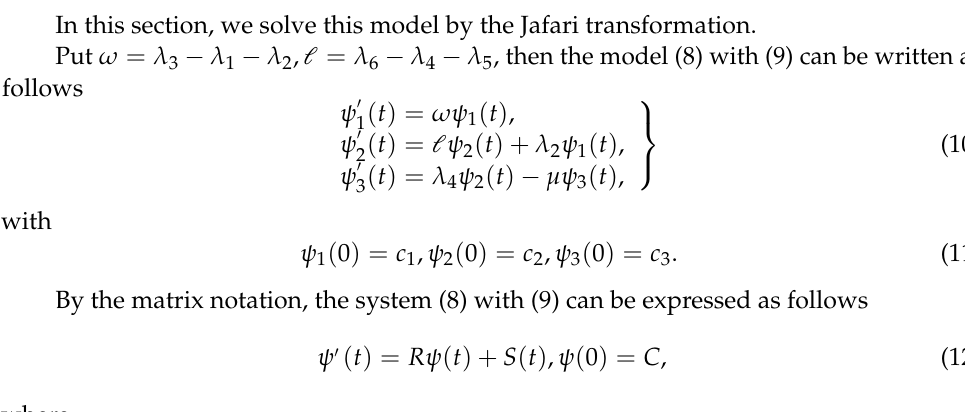
Table 2. The natural explanation of the parameters. Parameter Meaning ψ 1 ( t ) number of stem cells ψ 2 ( t ) number of semi-differentiated cells ψ 3 ( t ) number of differentiated cells the cell death rates in stem cells the number of stem cells that become semi-differentiated λ 3 the cell renewal rates of stem cells λ 4 the cell death rates in semi-differentiated cells the number of the semi-differentiated cells that become λ 5 differentiated cells λ 6 the cell renewal rates of semi-differentiated cells